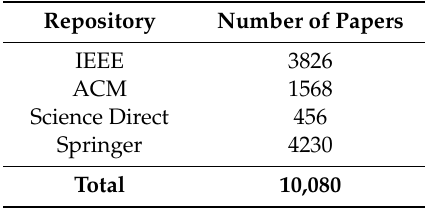
Table 1. Number of papers extracted according to the quality assessment criteria.